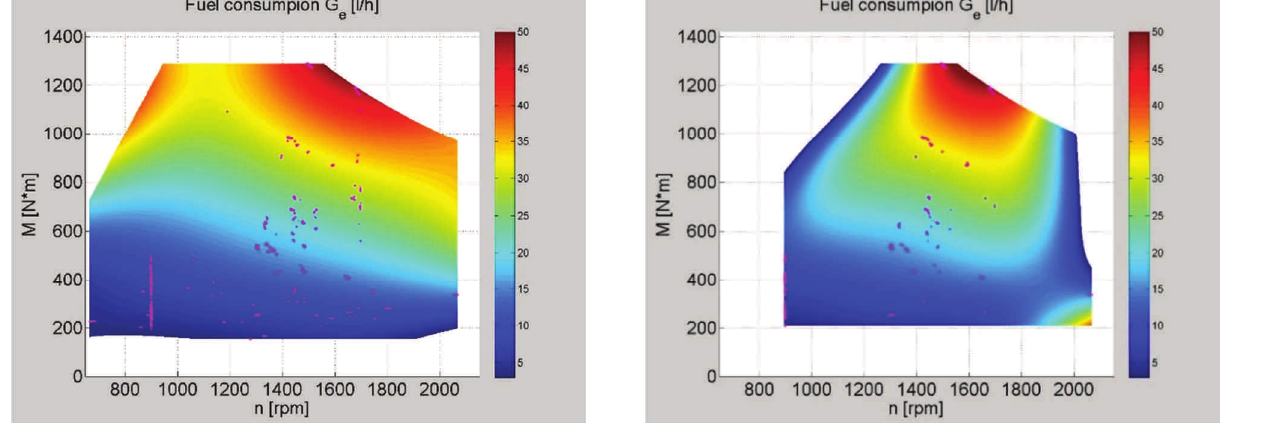
Fig. 8. Characteristics obtained from operational data: static state duration 2 s; derivative limits: 5 N ∙ m/s, 5 rpm/s